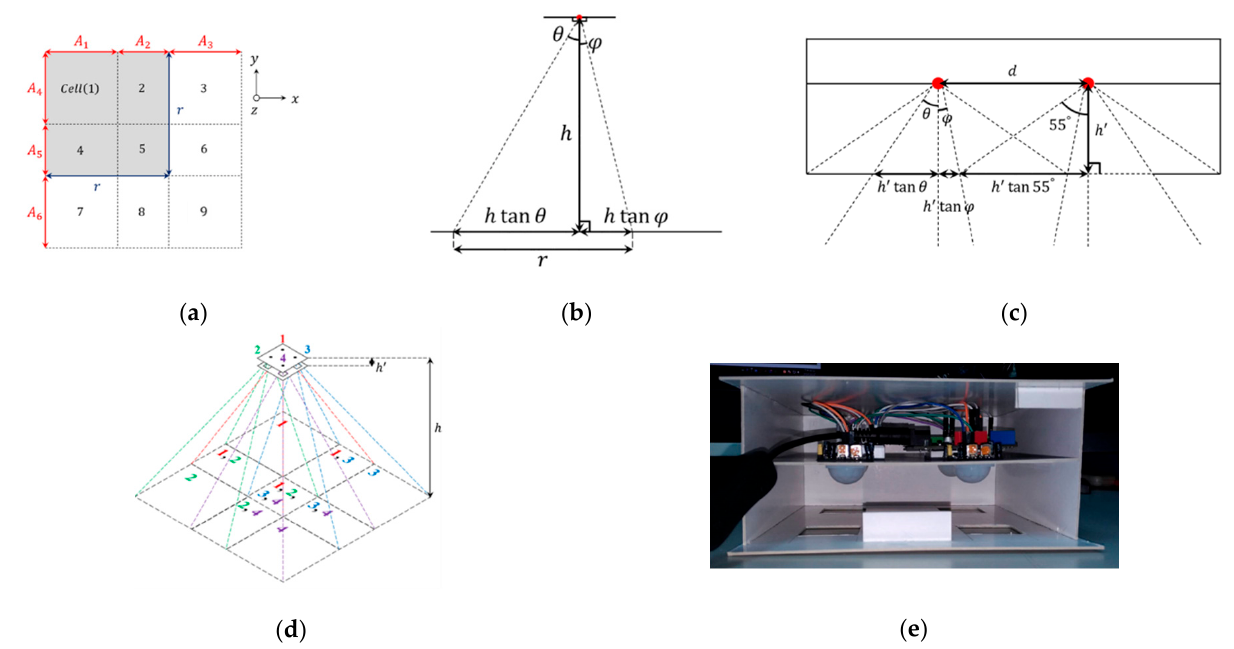
Figure 2. A PIR detector: ( a ) the top view of the detection area, ( b ) the detection area of a PIR module, ( c ) parameters of the reference structure, ( d ) the full view of a PIR detector, and ( e ) the inside view of the reference structure.